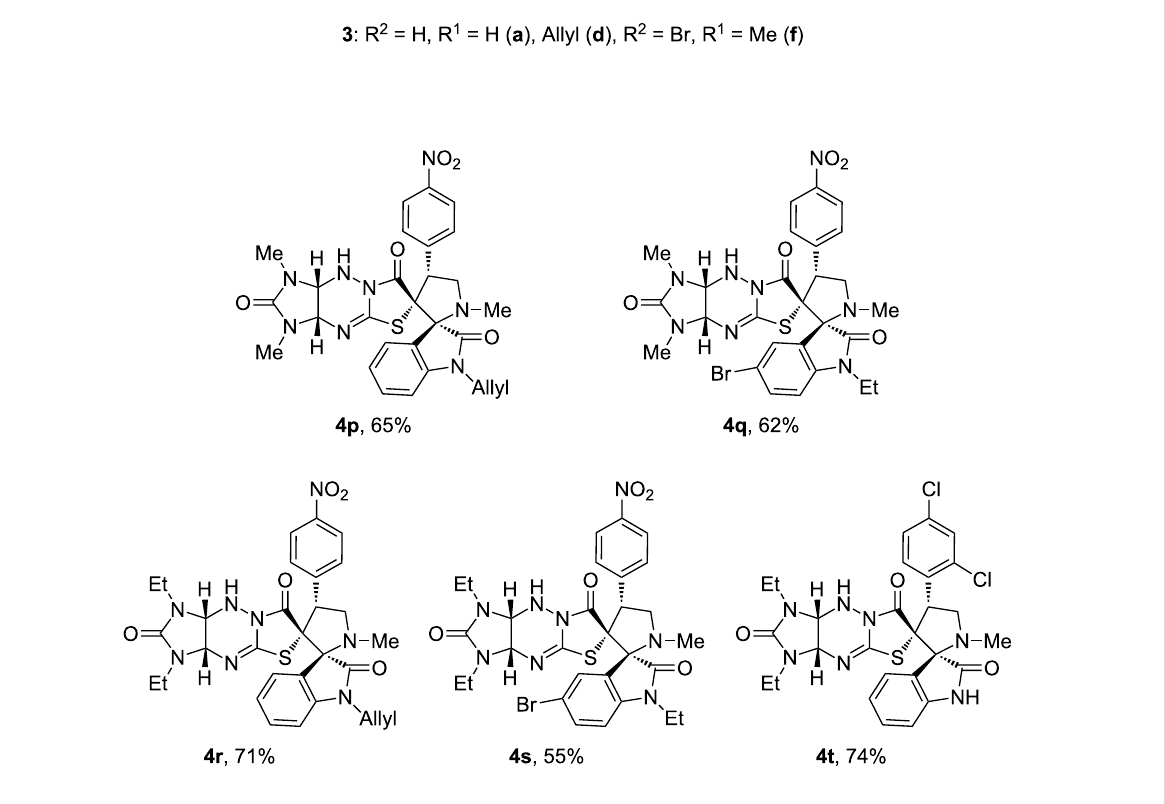
Figure 3: Synthesis of dispiro compounds 4p–t . Reaction conditions: heating the solution of compounds 1 (0.5 mmol), isatins 3 (0.5 mmol), and sarcosine (0.5 mmol) in the mixture of acetonitrile (30 mL) and chloroform (10 mL) for 72